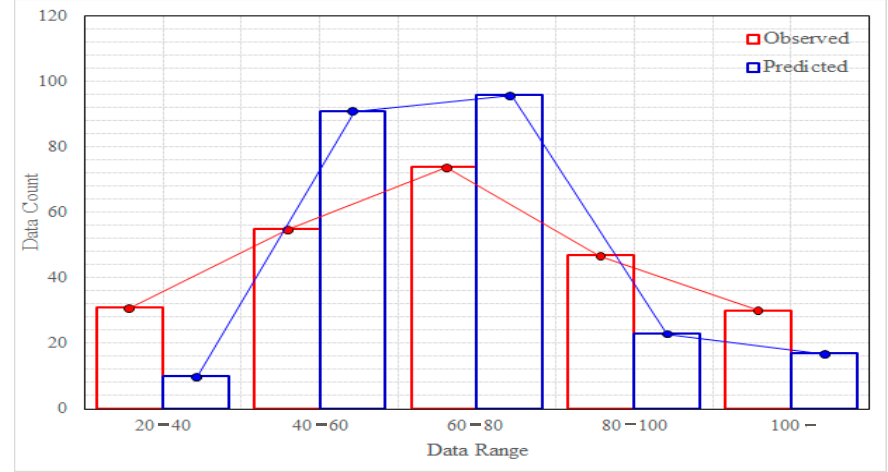
Figure 10. Threshold rainfall distribution.